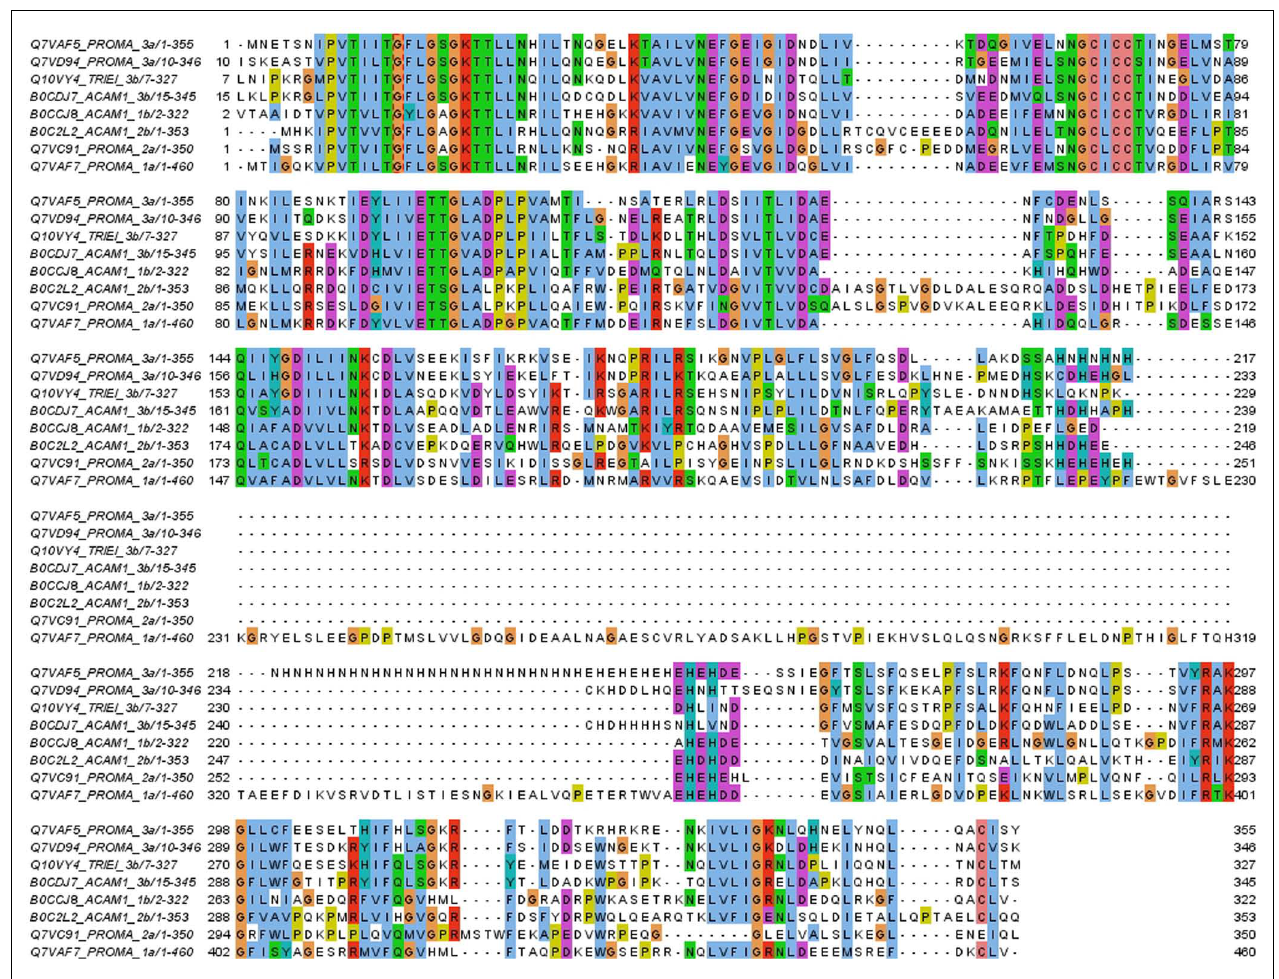
location in the phylogenetic tree (see Figure 6 ).The first three rows correspond to the GTPase domain.This is followed by a highly variable section. Group 1a is characterized by ca. 150 aa long inserts with no His residues. Inserts of medium length are found for some representatives of group 3.Very short linkers between the N-terminal GTPase domain and the C-terminal domain (which is relatively well-conserved again) are found in all three major